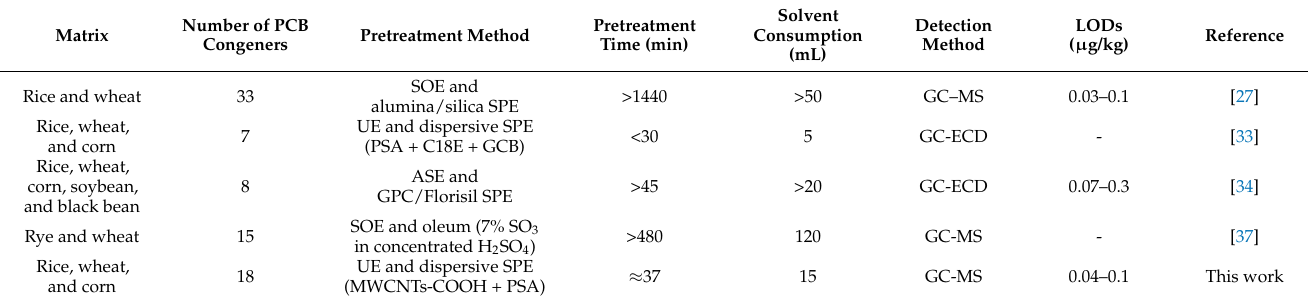
Table 1. Comparison of the developed method with previously reported